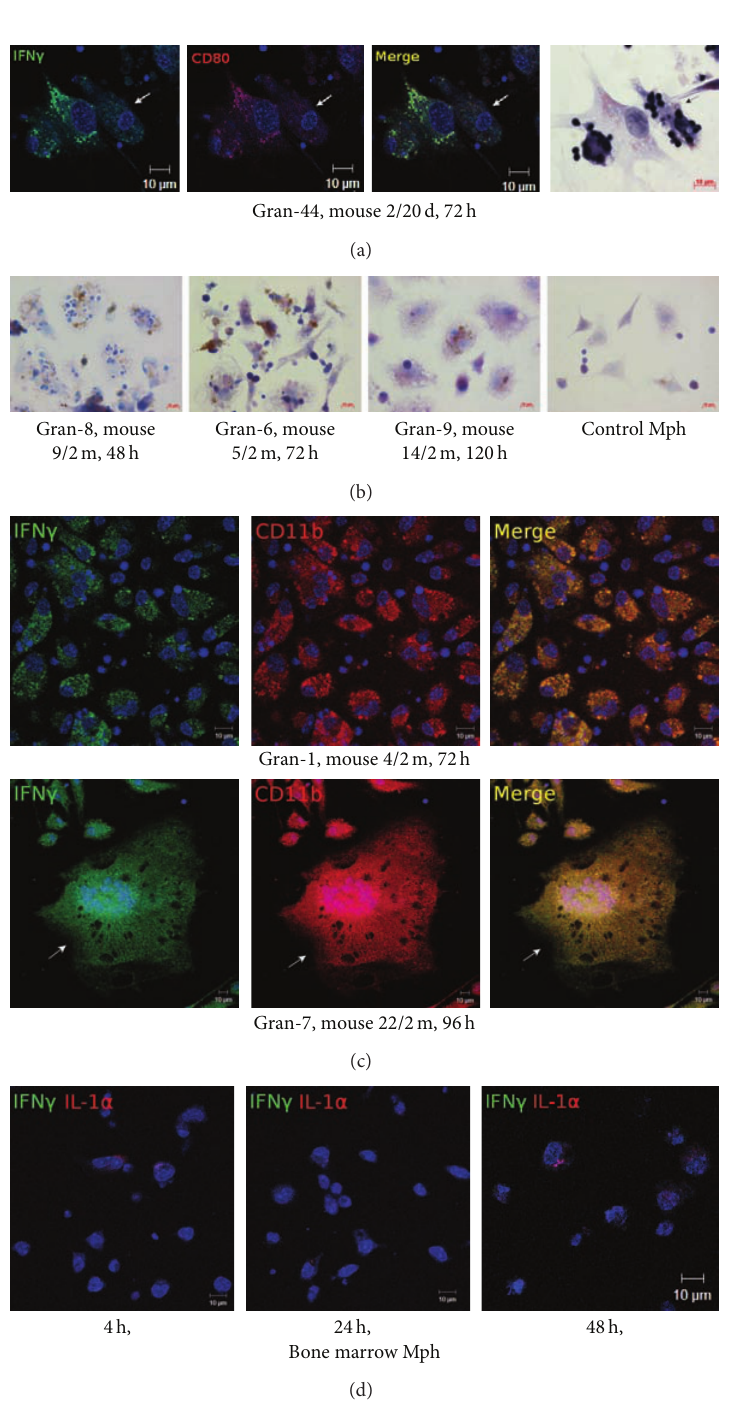
Figure6:((a)–(c))ThecellswithIFN 𝛾 inthefragmentsofmousesplenicgranulomas.Thescalebarsare10 𝜇 meach.((a),(c))Colocalizationof themarkersontheconfocalimagesofcells(yellowsignal).((a),(c)-(d))NucleistainedbyDAPI(bluesignal).(a)Confocalimmunofluorescent localization of IFN 𝛾 (green signal) and CD80 (red signal) in granuloma macrophages (Mph) and a fibroblast at the center of the images. In the right panel, the same fragment as in the other panels restained for acid-fast BCG-mycobacteria by the ZN method. An IFN 𝛾 -producing macrophage with BCG-mycobacteria reproducing in it is indicated by the white arrows on the fluorescent images and the black arrow on the ZN image. (b) Immunochemical localization of IFN 𝛾 in granuloma cells and control mouse peritoneal macrophages. The brown color indicates the presence of IFN 𝛾 in these cells. (c) Confocal immunofluorescent localization of IFN 𝛾 (green signal) and CD11b (red signal) in granuloma macrophages, with a multinucleate Langhans giant cell indicated by the white arrows in the three lower panels. (d) Bone marrow macrophages following infection with the BCG vaccine in vitro and after culture for several hours not stained by the IFN 𝛾 - (green signal) and IL-1 𝛼 -specific antibodies (red signal) on the confocal fluorescent images. Abbreviations as in Figure